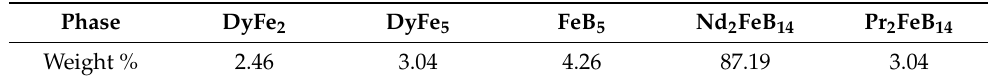
Table 2. Rietveld XRD quantitative analysis of the NdFeB magnets.